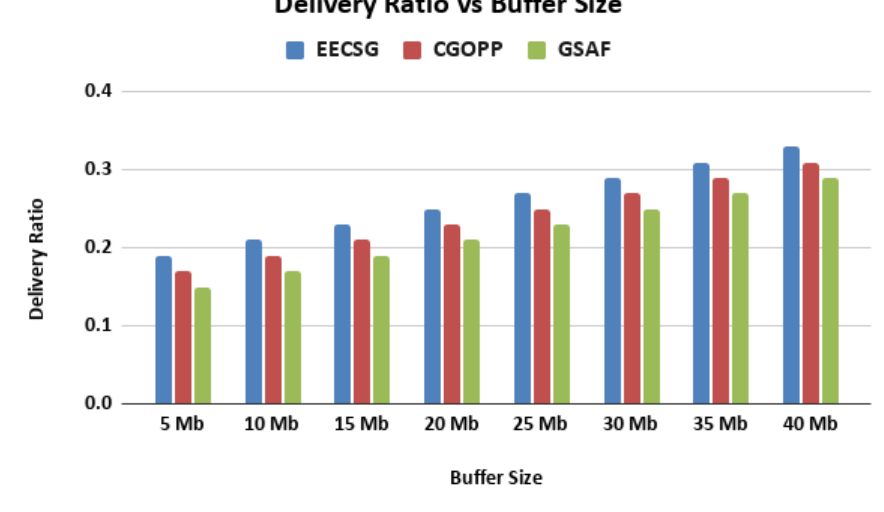
Figure 6. Delivery ratio vs. buffer size.